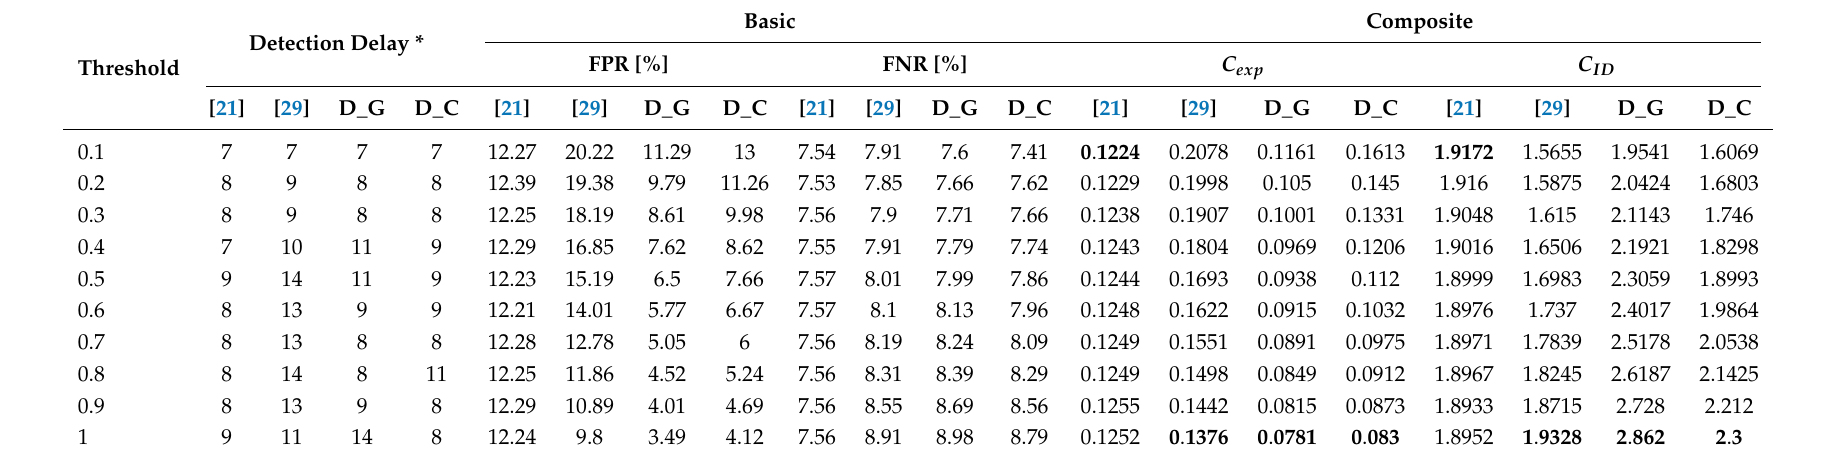
Table 1. Comparison of detection results with available